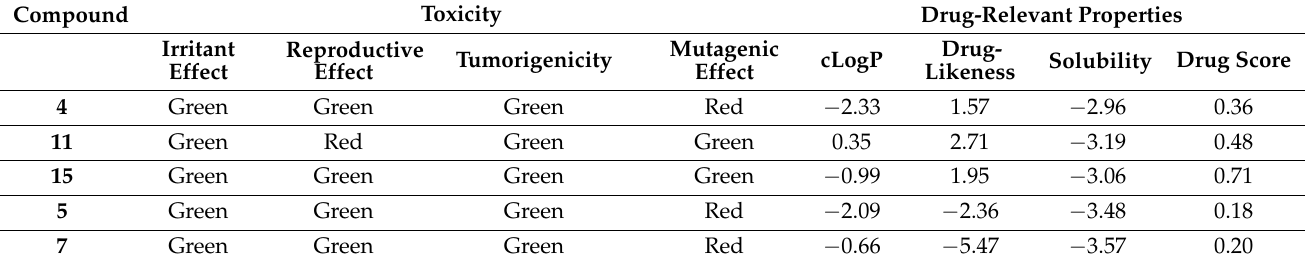
Table 3. Drug relevant and toxicity prediction scores of flavonoid acetamide derivatives from Osiris property